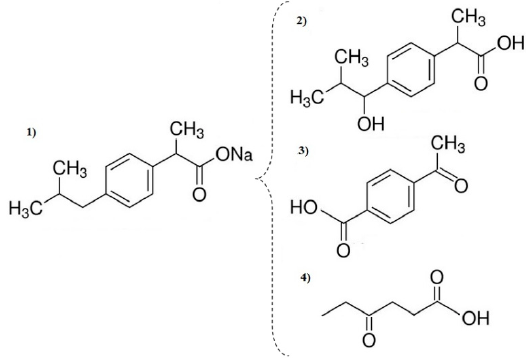
Figure 7. Identified 1 ibuprofen sodium salt by-products, where 2 is 1-hydroxyibuprofen, 3 is 4-acetylbenzoic acid and 4 4-oxohexanoate.